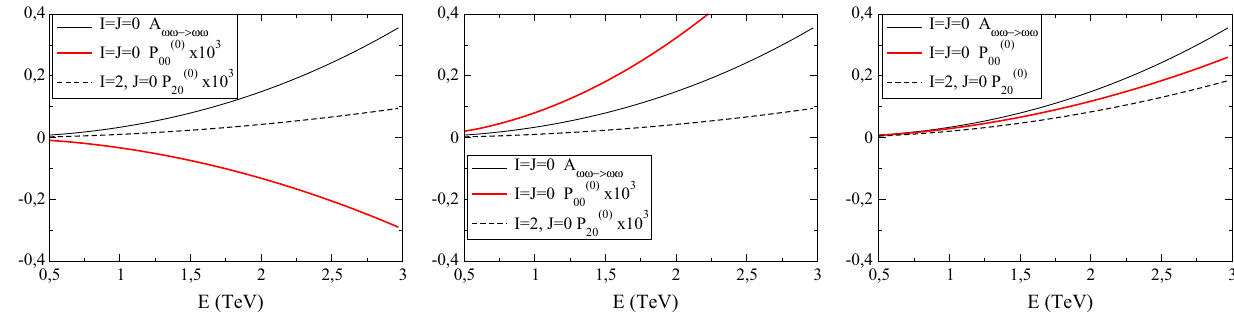
a 1 = a 2 = a 3 = 0. Right c γ = 0 = a 1 , a 3 − a 2 = 0 . 3. Note that in the first two plots the P amplitudes have been multiplied by a factor 10 3 for visibility; not so in the third